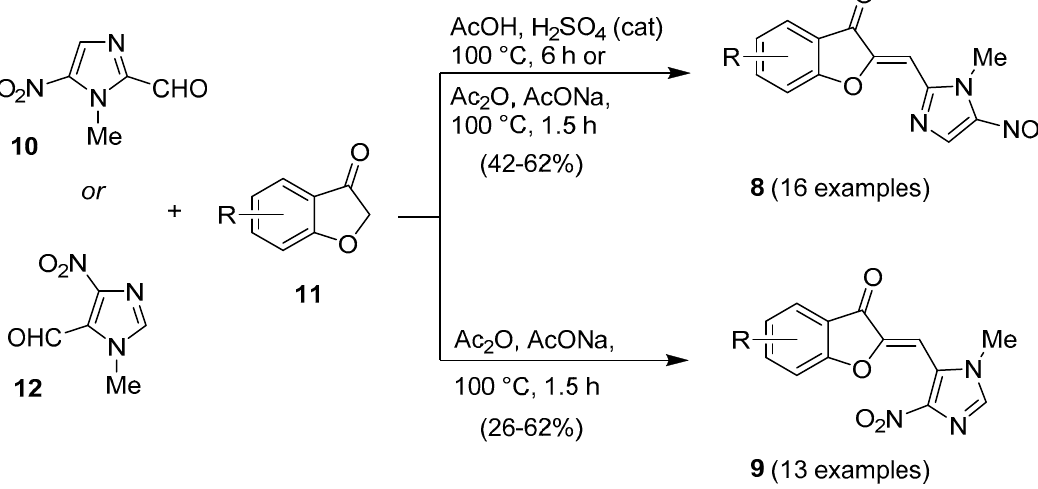
Scheme 2. Synthesis of hybrids 8 and 9